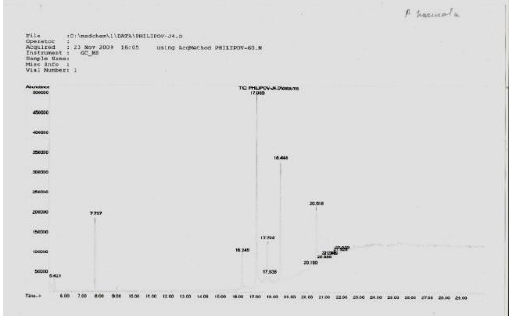
Figure 1.GC-MS data of Peganum harmala